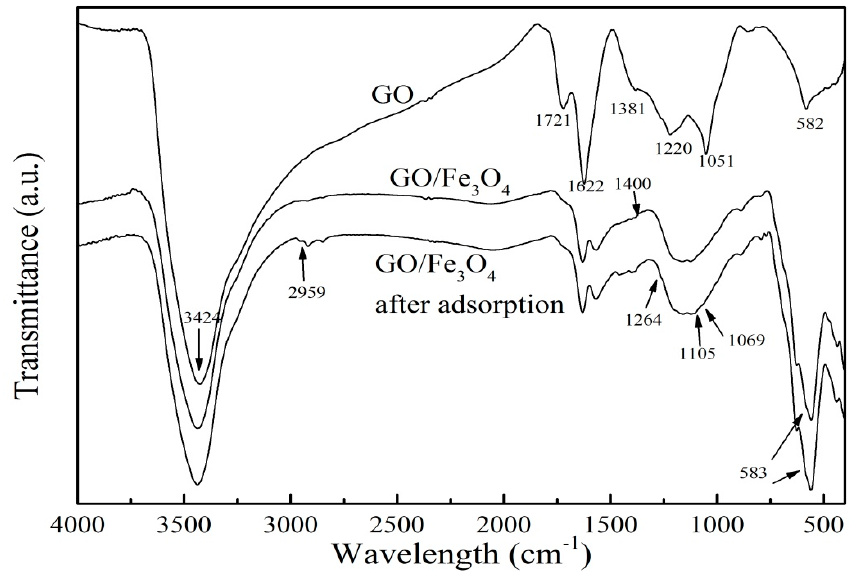
/ Fe 3 O 4 , and GO 3 O 4 after